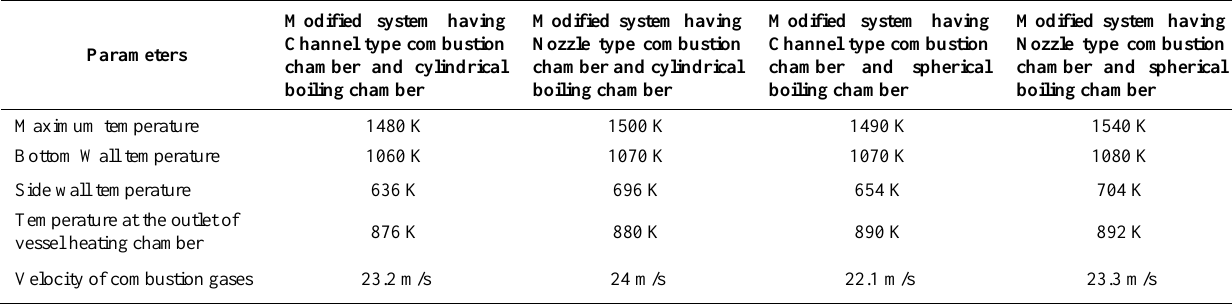
Figure 6. Contours of velocity (m/s) for the four different modified systems. Table 1. Results from the CFD analysis of the four different modified